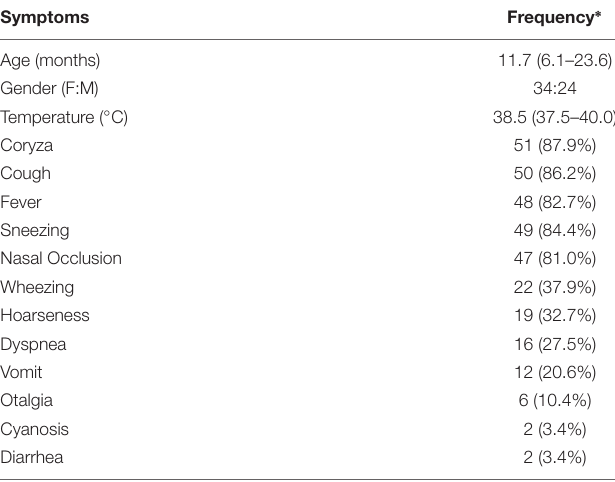
TABLE 1 | Demographic and clinical characteristics of children with ARI ( n =